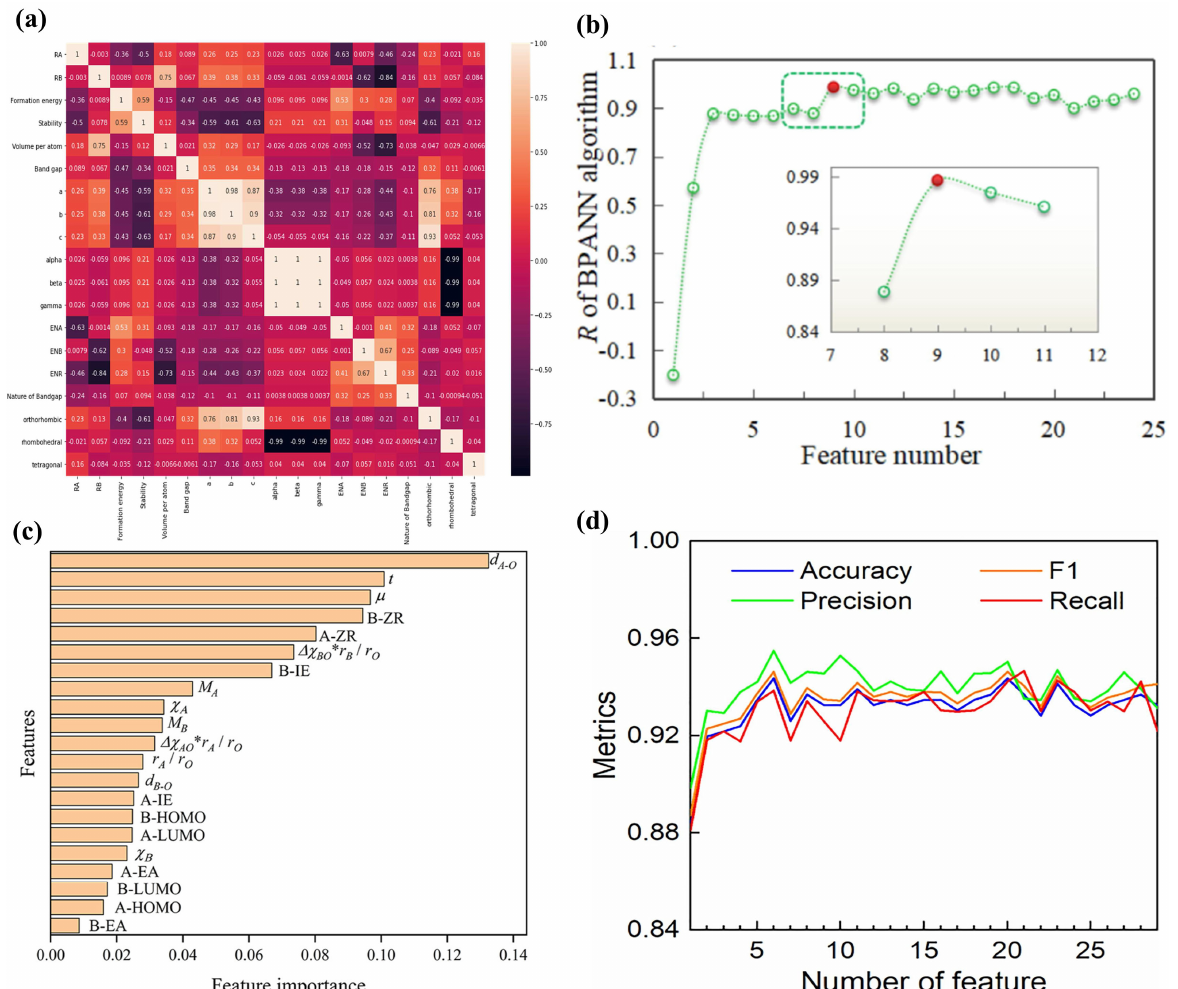
Figure 4. Applications of feature selection in inorganic perovskites. ( a ) A heat map of the correlation between features. Reprinted with permission from ref. [95]. Copyright 2022 Elsevier. ( b ) For R of the LOOCV in the feature selection process of the R H model, the position of the red point is the maximum value of R. Reprinted with permission from ref. [30]. Copyright 2021